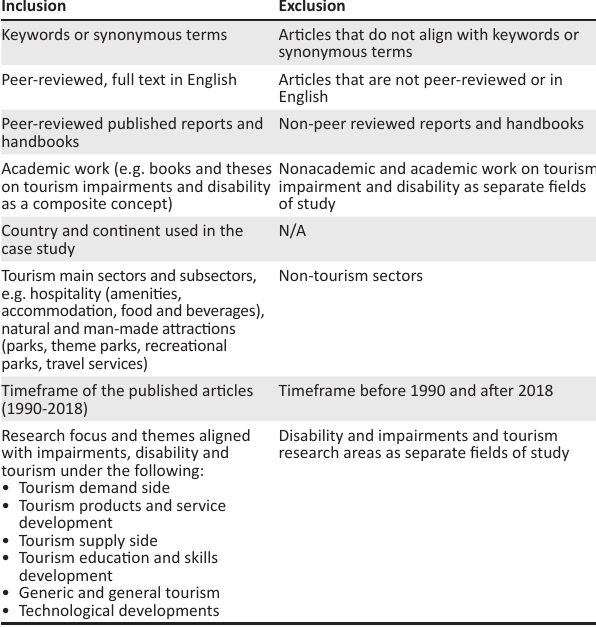
TABLE 2: Review inclusion and exclusion criteria.